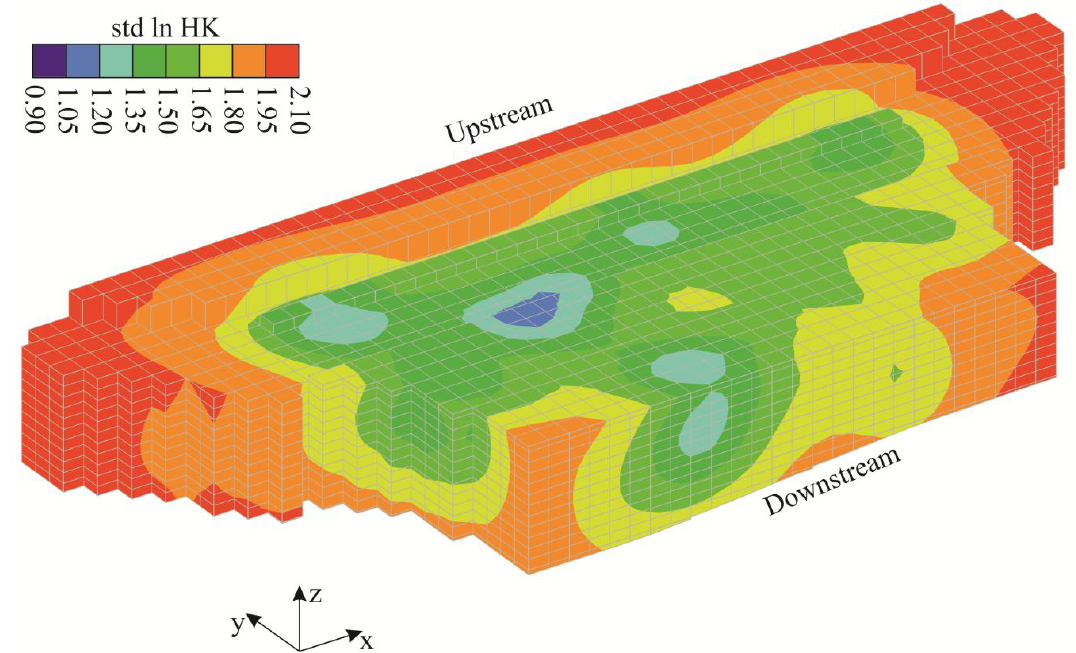
Figure 10. Three-dimensional view of the standard deviation (SD) of the estimated hydraulic conductivity field. The results are reported in terms of natural logarithm of the parameters (ln HK) with units m/s in the physical space.